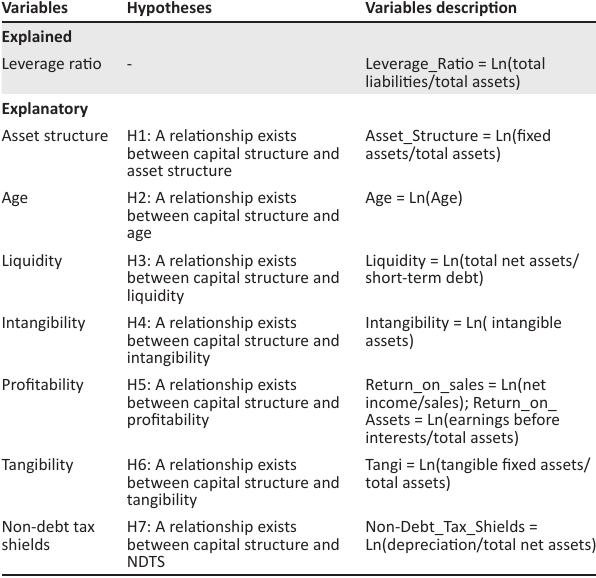
TABLE 1: Explained variables, explanatory variables and